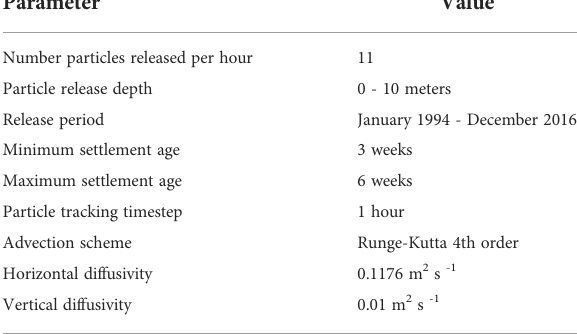
TABLE 1 Parameters for particle